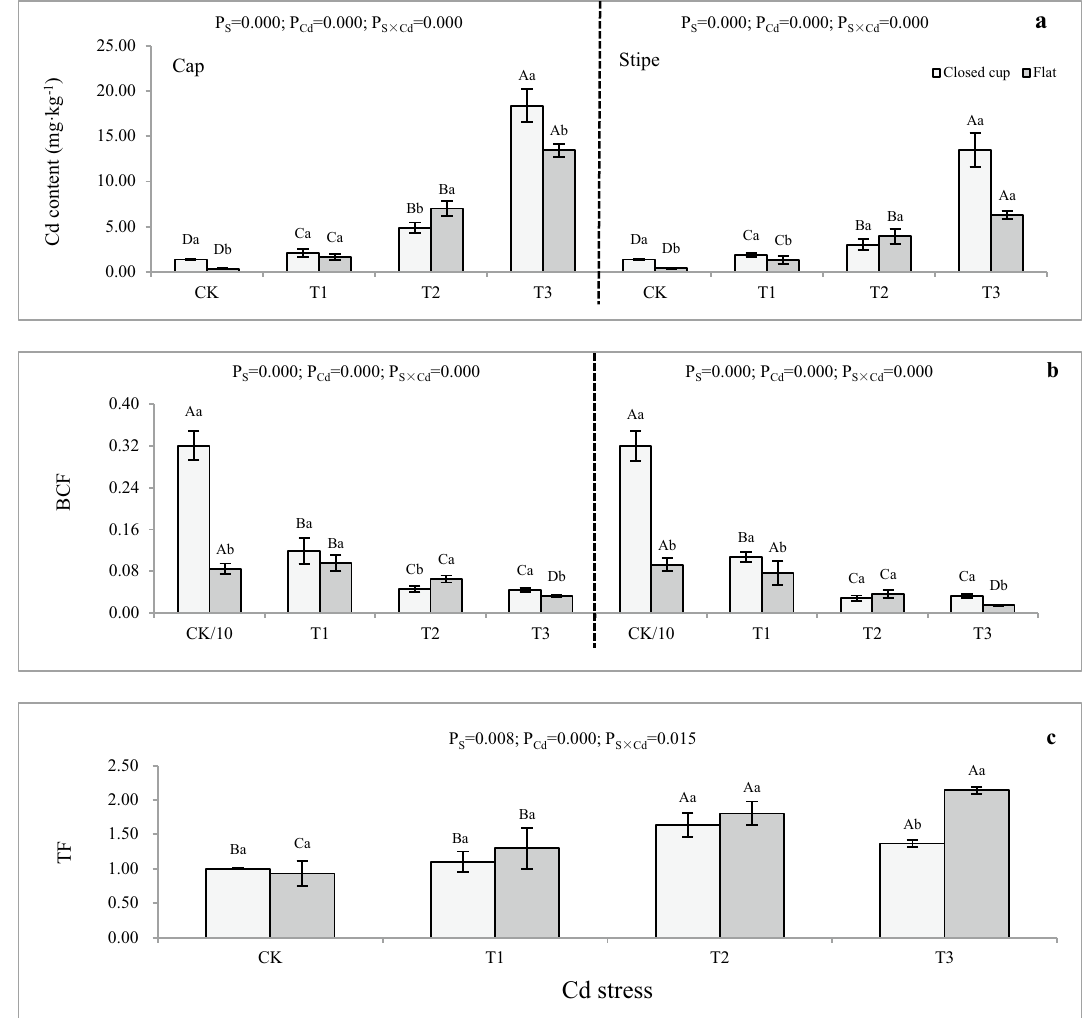
Figure 1. Cd concentration, BCF and TF in fruiting bodies of A. bisporus . ( a ) Cd concentration in the cap and stipe. ( b ) BCF in the cap and stipe. ( c ) TF in the fruiting body. Different capital letters indicate significant differences among Cd stresses under the same sampling stage determined by LSD’s test with p < 0.05; different lower letters indicate significant differences within the sampling stage under the same Cd stress concentration determined by LSD’s test with p < 0.05. P S : effect of sampling time; P Cd : effect of Cd concentration; P S×Cd : Interaction between sampling time and Cd concentration. Error bar: